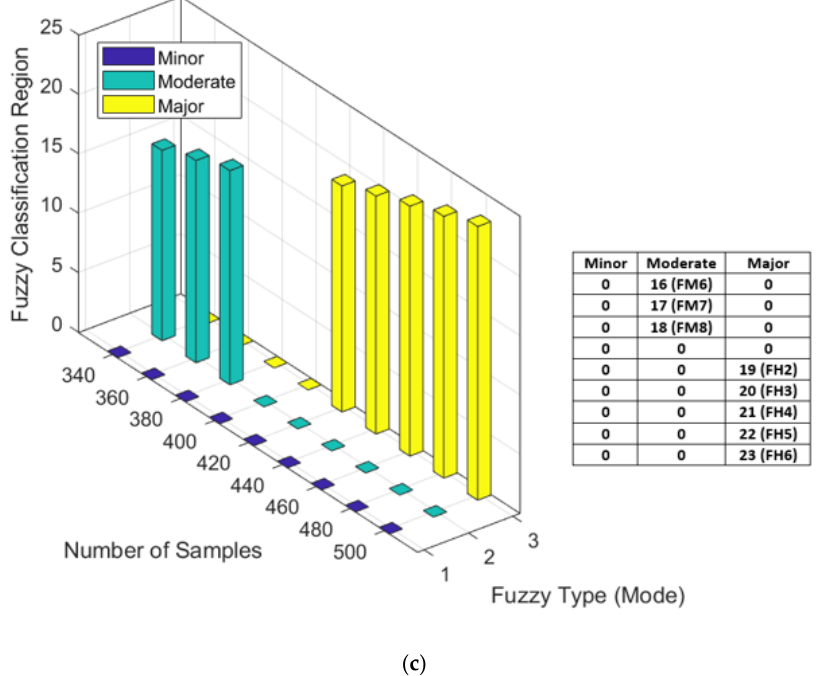
Figure 15. The Sugeno fuzzy logic system output results ( a ) from 8:00 to 10:20, ( b ) from 10:40–13:20, ( c ) from 13:40–16:20.